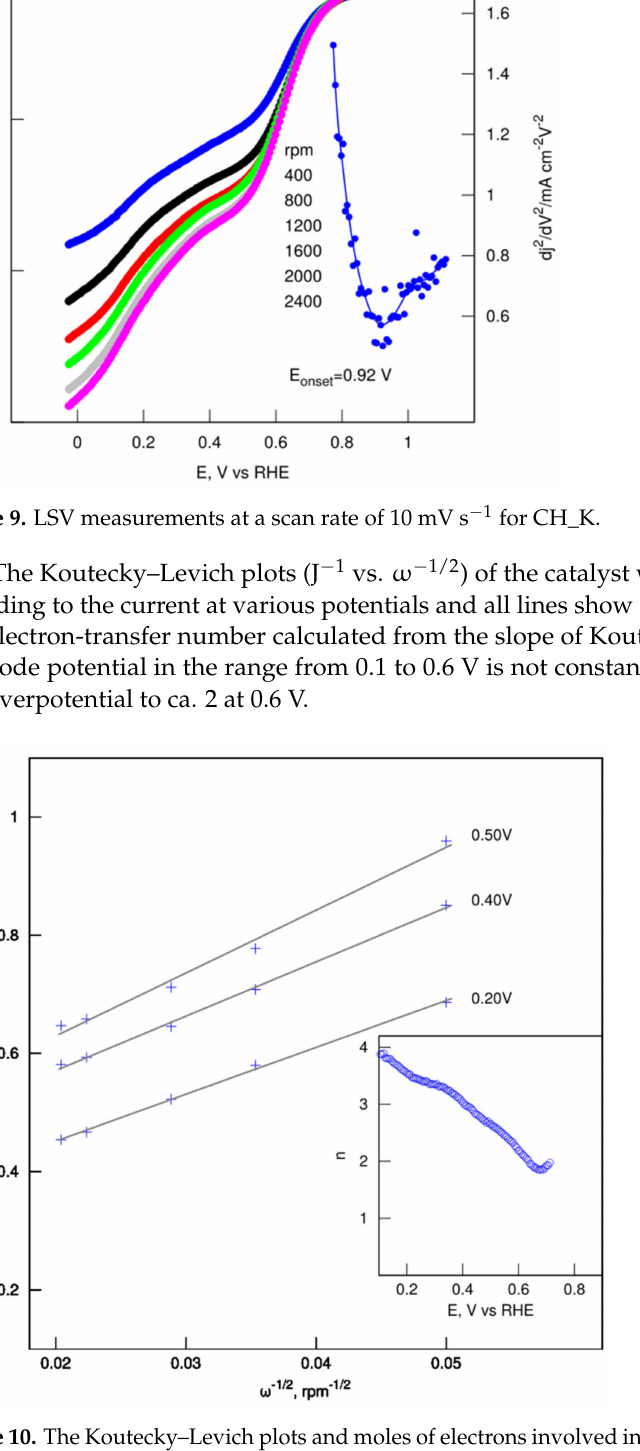
Figure 10. The Koutecky–Levich plots and moles of electrons involved in the ORR for CH_K catalysts. The changing electron transfer number implies that the catalytic sites in the material vary in terms of adsorption affinity of oxygen onto them [35]. At low overpotential, those that catalyse 4-electron reduction of oxygen to water are more active: O 2 + 2H 2 O + 4e − = 4OH − ; whereas at higher voltages, reduction of oxygen